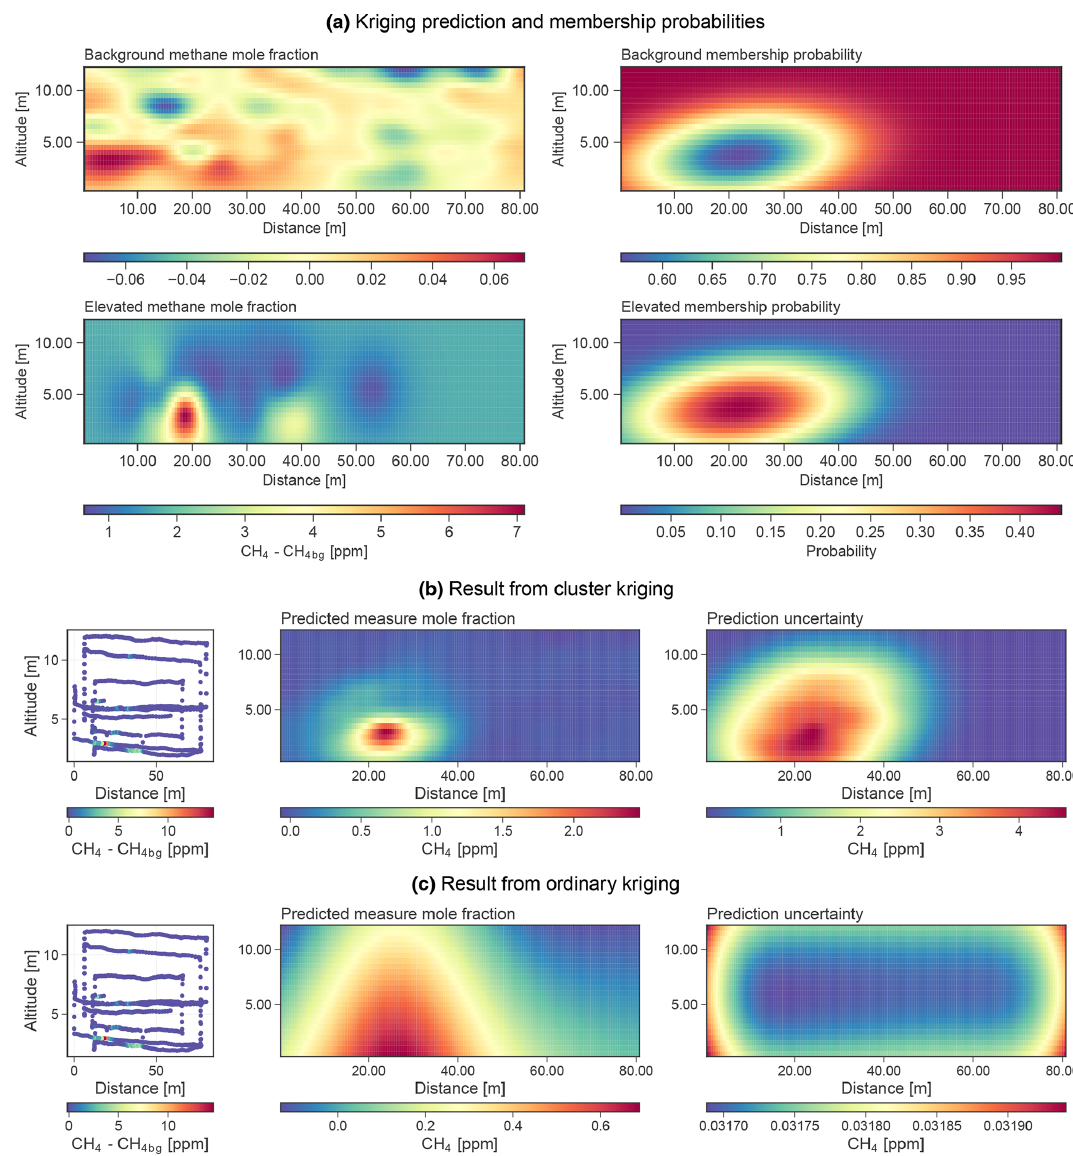
Figure 6. (a) Kriging prediction and membership probabilities of each spatial point within the domain of interest for background and elevated clusters. (b) Expected value and variance of methane mole fractions after combining kriging prediction of the two clusters and their respective membership probabilities. (c) Expected value and variance of methane mole fractions using ordinary